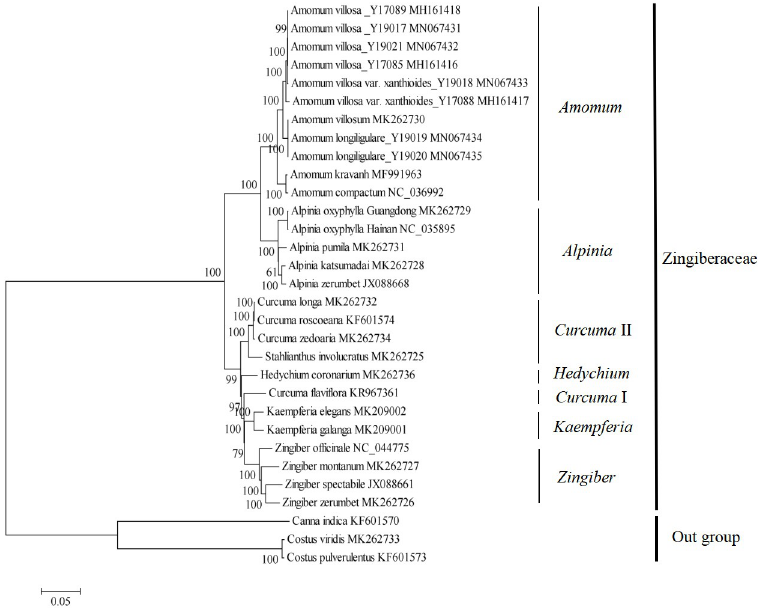
Fig 9. Phylogenetic relationships constructed with SNPs from 31 chloroplast genomes using the maximum likelihood method. The bootstrap values were based on 1,000 replicates and are indicated next to the branches.